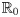
Histogram for R0.Histograms from 1000 realizations of R0 for DENV, ZIKV and CHIKV when Wolbachia-infected and Wolbachia-free Ae. aegypti mosquitoes. The baseline parameters in Table 2 were sampled from a triangular distribution having the mode at the baseline values and vanishing at the edges of the feasibility region. The mean and median of Zika are the largest. (a) When DENV is transmitted by wAlbB-infected mosquitoes, median and mean of R0 are 2.94 and 3.13, respectively. (b) When DENV is transmitted by wMel-infected mosquitoes, median and mean of R0 are 2.30 and 2.48, respectively. (c) When DENV is transmitted by Wolbachia-free mosquitoes, median and mean of R0 are 3.65 and 3.84, respectively. (d) When CHIKV is transmitted by wAlbB-infected mosquitoes, median and mean of R0 are 0.88 and 0.92, respectively. (e) When CHIKV is transmitted by wMel-infected mosquitoes, median and mean of R0 are 0.73 and 0.76, respectively. (f) CHIKV transmitted by Wolbachia-free mosquitoes, median and mean of R0 are 1.14 and 1.19, respectively. (g) When ZIKV is transmitted by wAlbB-infected mosquitoes, median and mean of R0 are 3.10 and 3.28, respectively. (h) When ZIKV is transmitted by wMel-infected mosquitoes, median and mean of R0 are 2.45 and 2.62, respectively. (i) When ZIKV is transmitted by Wolbachia-free mosquitoes, median and mean of R0 are 3.79 and 4.03, respectively.